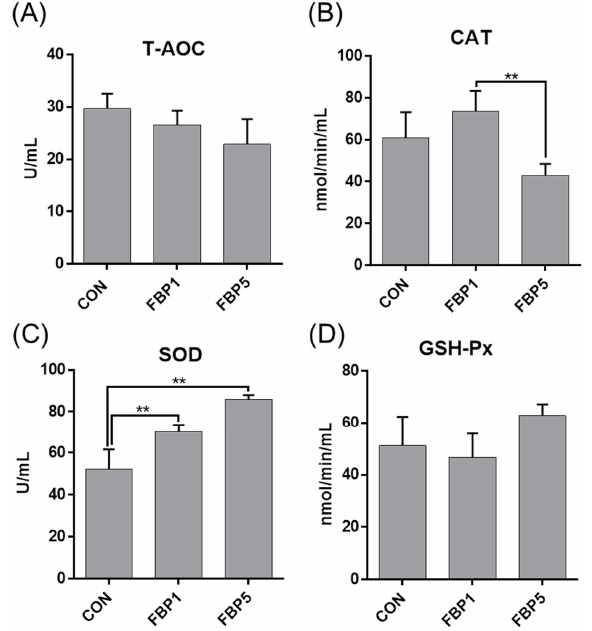
Figure 6. Dietary effects of the Lp-fermented B. papyrifera product (FBP) under practical condition on serum antioxidant of laying hens. ( A ) Total antioxidant capacity (T-AOC), ( B ) catalase activity, ( C ) superoxide oxidase (SOD), and ( D ) glutathione peroxidase (GSH-Px). Con: the hens fed with basal diet; FBP1, the hens fed with 1% (wt/wt) FBP product in basal diet; FBP5, the hens fed with 5% (wt/wt) FBP product in basal diet. ** indicates significant difference among the treatments at p < 0.01 level.